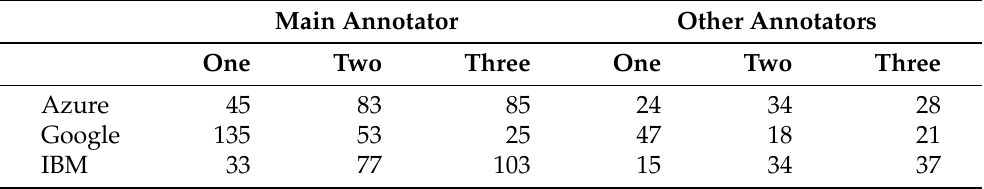
Table 2. Number of sentences of the three MT providers selected as best (one), second, or third.